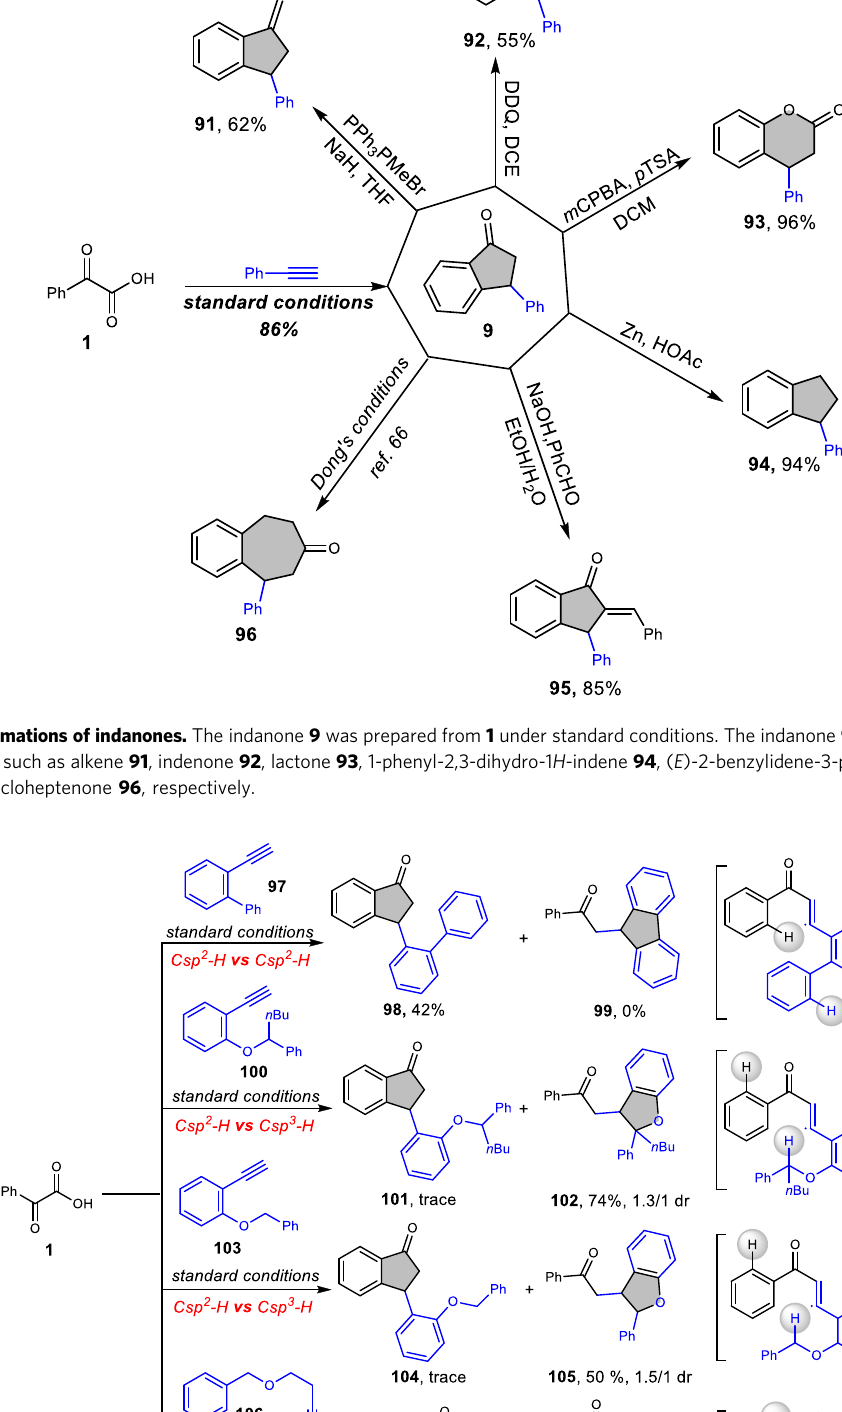
NATURE COMMUNICATIONS| (2021) 12:5257